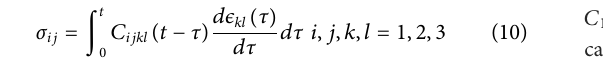
C (cid:2) C 23 32 . Each of these relaxation functions